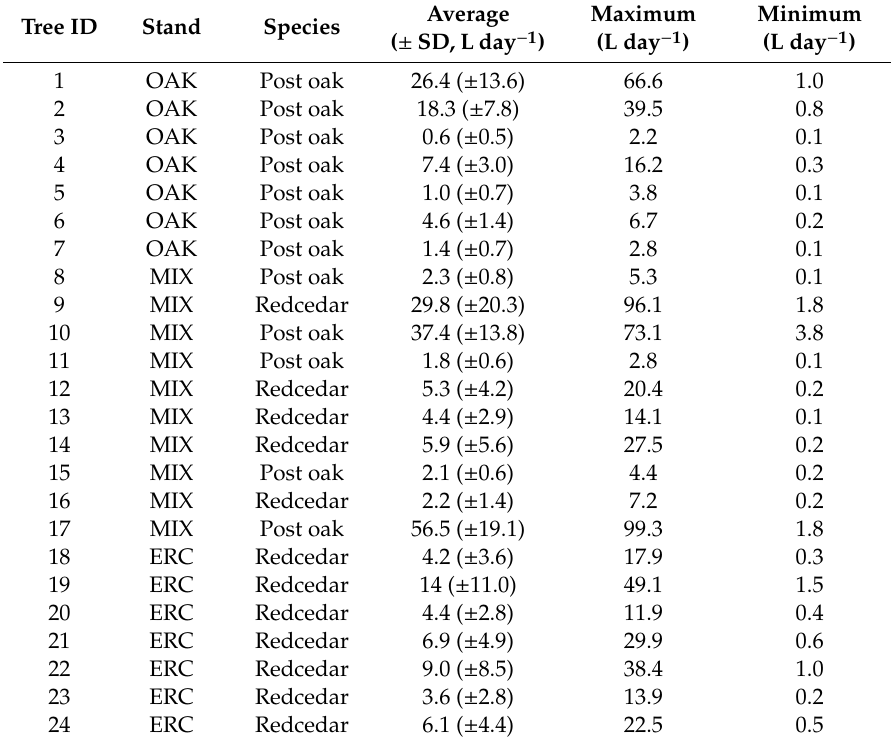
Table 3. Daily average ( ± standard deviation; SD), maximum and minimum water use (L day − 1 ) of all trees equipped with thermal dissipation probes (TDPs) during the study period. The minimum value reported was selected from the days when there was active